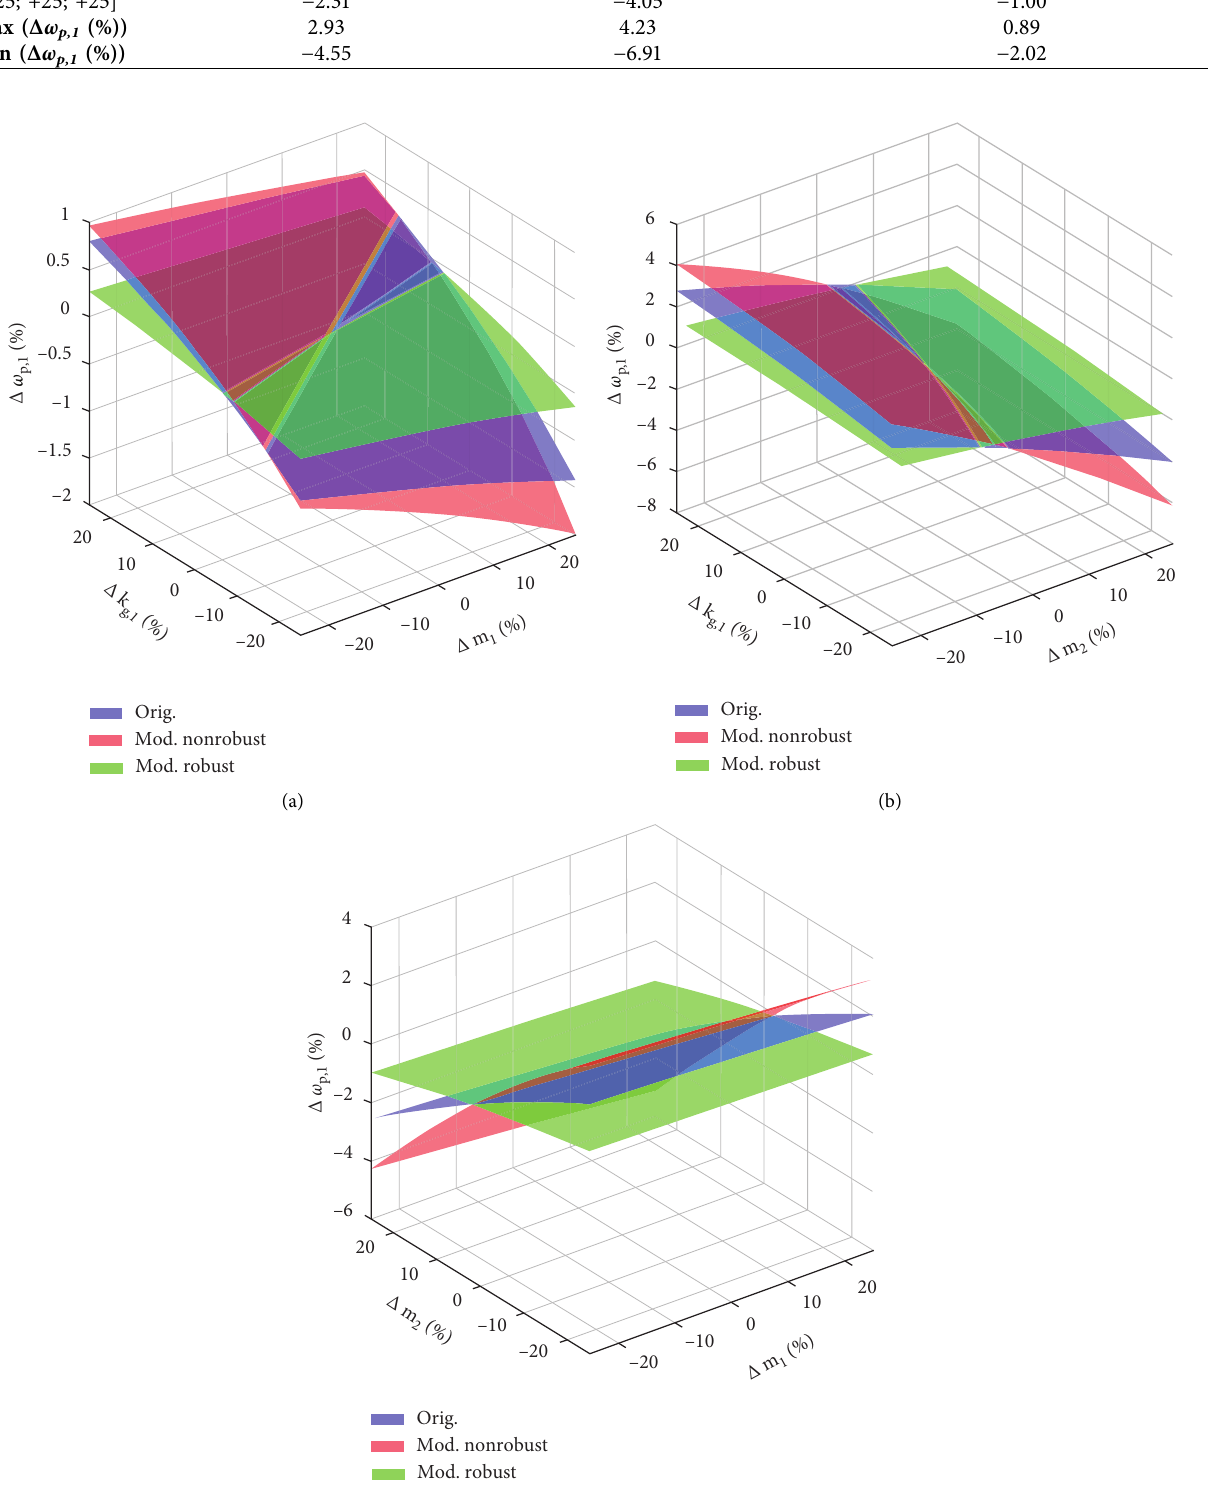
Figure 4: Test-case 1: percentage variation of the first natural frequency in the original and modified systems. (a) With fixed m fixed m 1 , and (c) with fixed kg 1